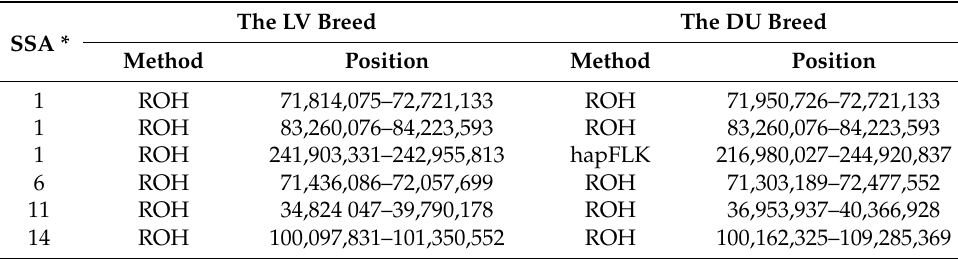
Table 3. Common selection signatures in the genome of pigs of the Duroc (DU) and the Livni (LV) breeds identified by the ROH or hapFLK